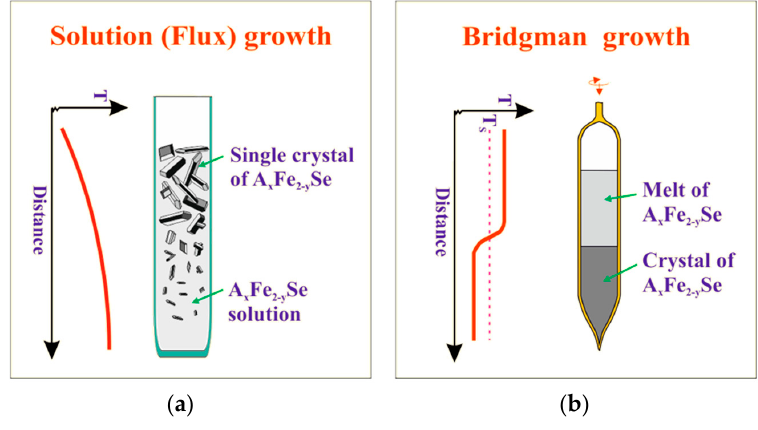
Figure 1. Schematic illustrations of the ( a ) self-flux; and ( b ) Bridgman growth methods.